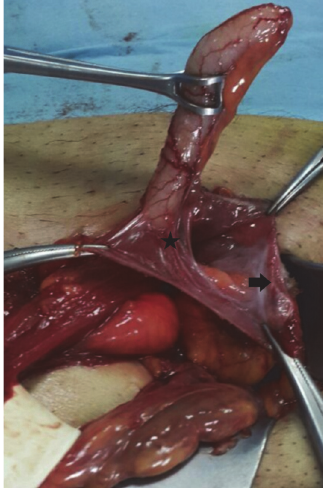
Figure 4: Minimally inflamed vermiform appendix in the inguinal hernia sac. Severe adhesions (star) between the vermiform appendix and surrounding hernia sac